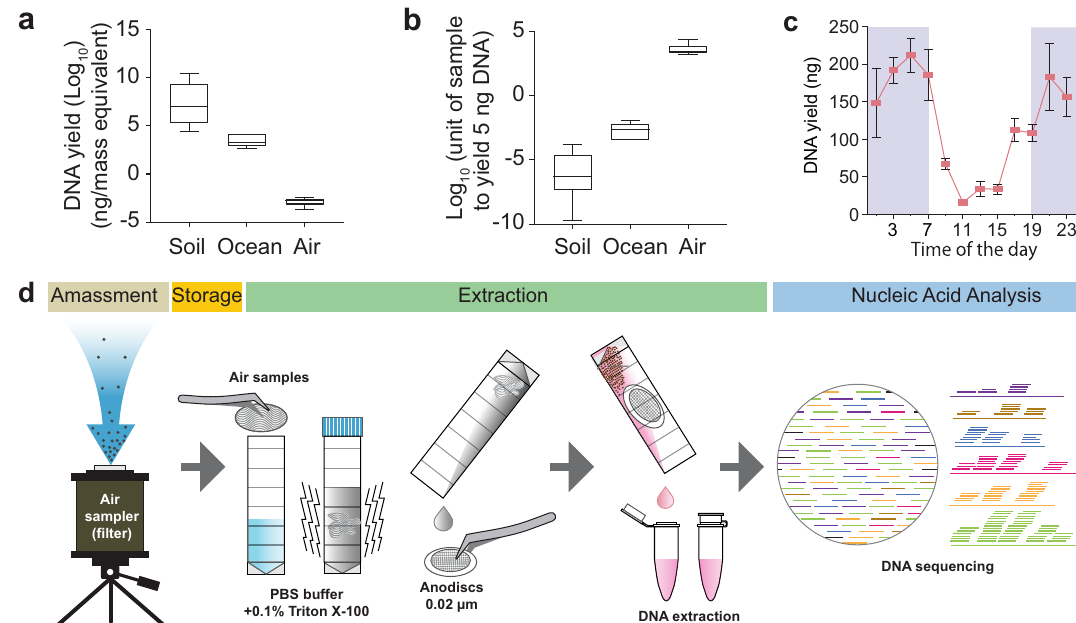
Fig. 1 Challenges in air microbiome analysis. a Total DNA yield (ng/mass equivalent) for soil, ocean water and air sample collected from the same proximity and processed with the same method. b estimated sample volume required to yield 5 ng of DNA. For box plots, the centre line, bound of box and whiskers represent median, 25th – 75th percentile and min-to-max values, respectively. c Fluctuation of airborne biomass (ng) at different times of the day. The red dots and error bars are mean and standard deviation among the replicates. d Developed sampling and analysis pipeline for metagenomic analysis of ultra-low biomass environmental